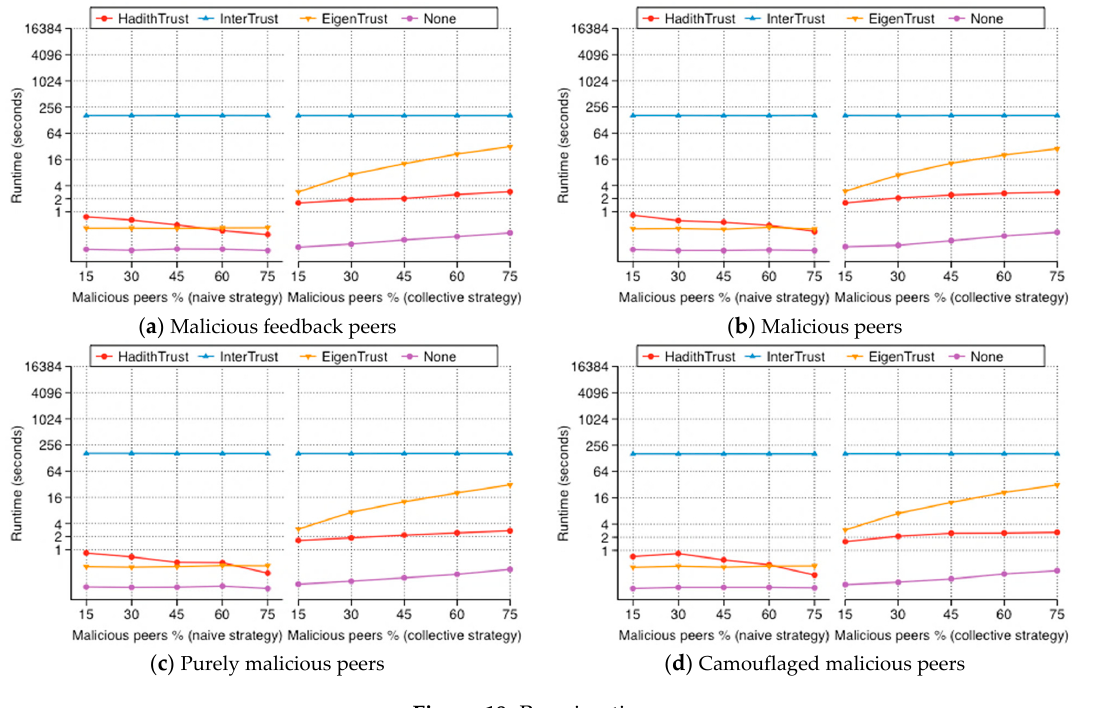
Figure 18. Running time.